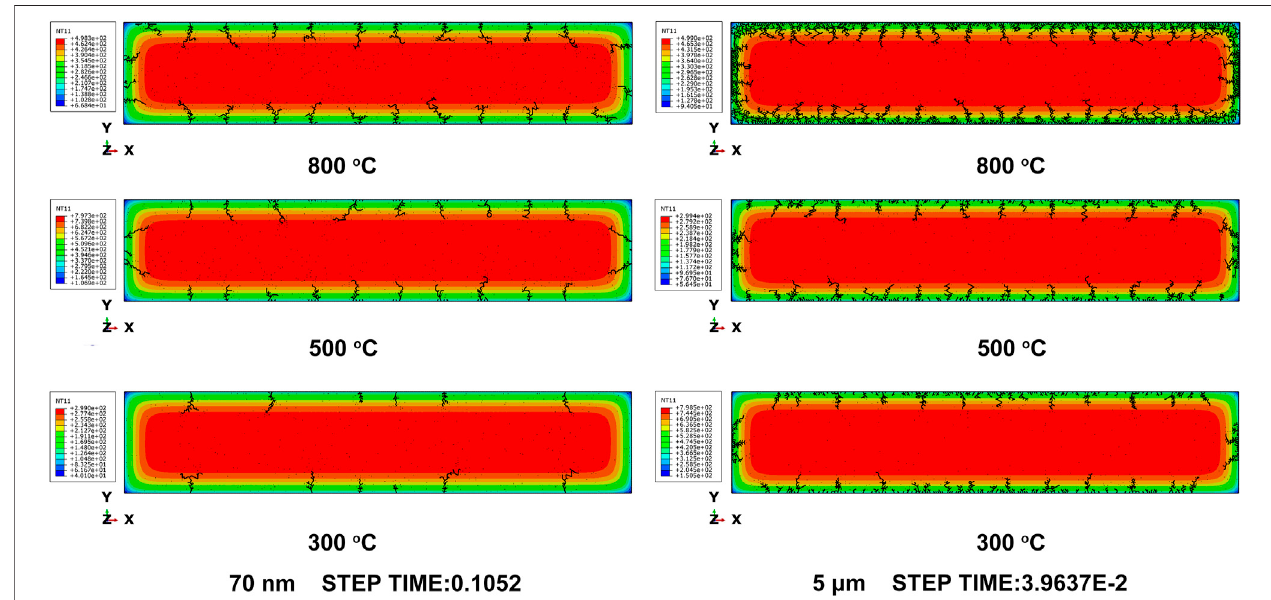
FIGURE 8 | Thermal crack patterns of the 70-nm model and 5- μ m model at T 0 (cid:2) 800, 500, and 300 ° C.